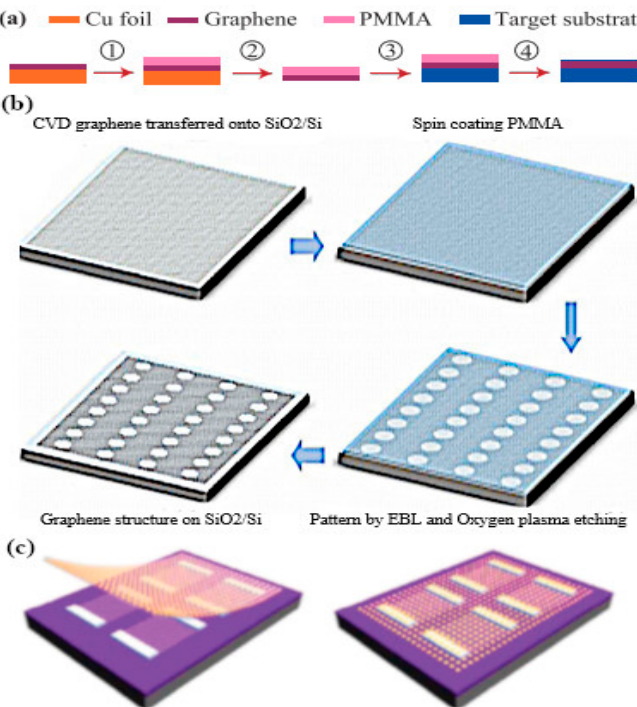
Figure 23. ( a ) Graphene transfer procedure schematic. ( b ) Patterning and fabrication of graphene antenna structure; the substrate with graphene is spin-coated with a PMMA layer then patterning is done through EBL and excess graphene is etched away through oxygen plasma. ( c ) Fabrication of graphene hybrid metal antenna; the metal is deposited when patterning is done, thereby integrating graphene with metal, providing a graphene–metal antenna. © 2017 PIER, © 2018 Springer, © 2011 Macmillan Publishers Limited. Reprinted with permission from